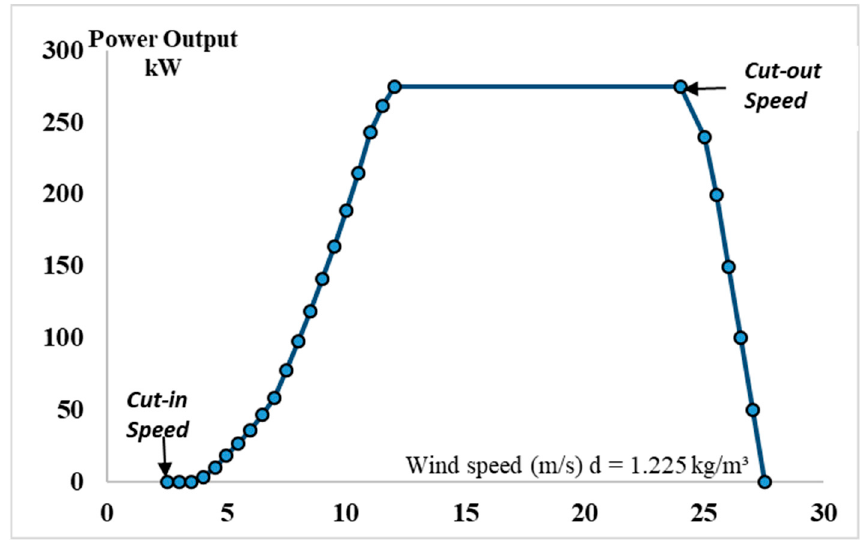
Figure 3. Power curve using actual data for the wind turbine understudy.